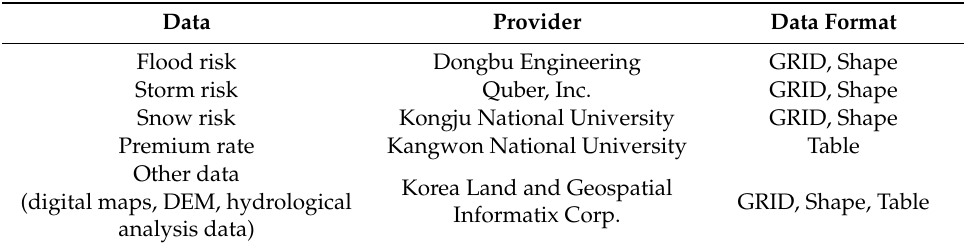
Table 1. Data, provider, and data formats.